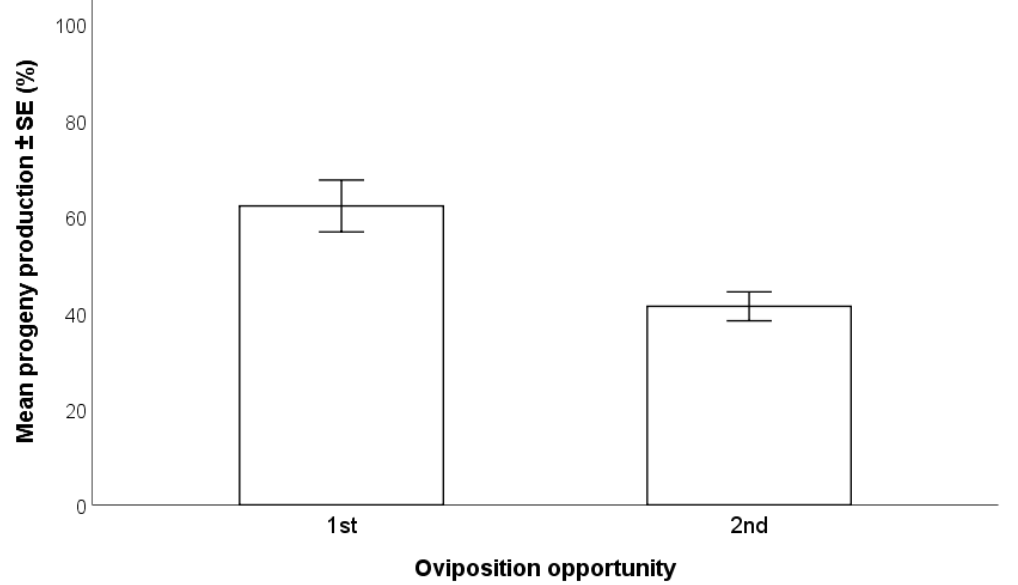
Figure 5. Effects of oviposition opportunity for the same Trissolcus japonicus females on the production of progeny (GLM, p < 0.001).